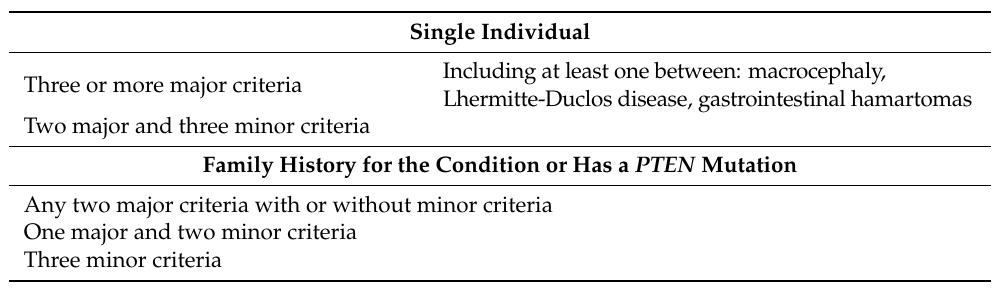
Table 4. Operational diagnosis.